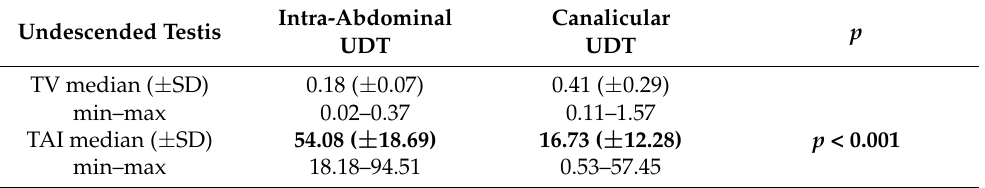
Table 5. TV and TAI of undescended gonads in intra-abdominal and canalicular UDT